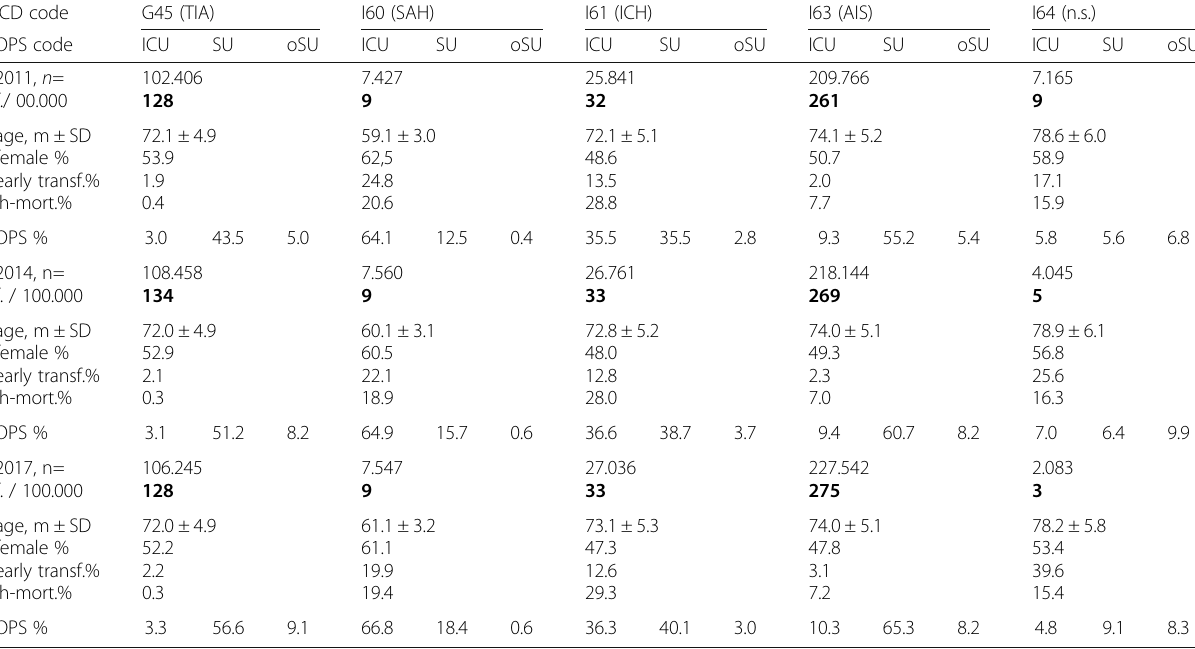
Table 2. The distribution of hospitalized patients with